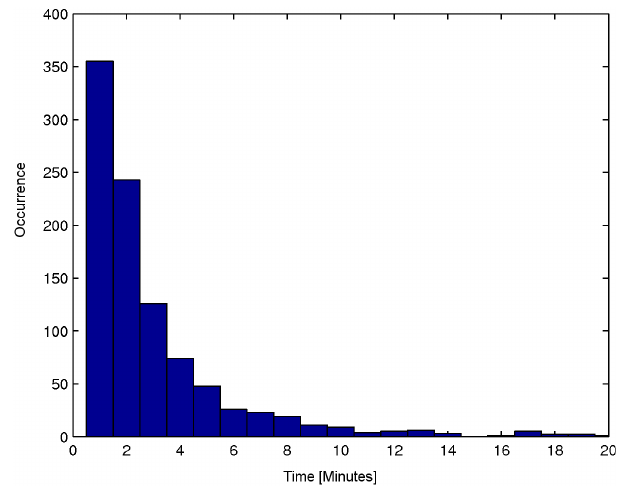
Fig. 10. Duration of continuously observed high electric field spec- tral density ( > 3(mVm − 1 ) 2 Hz − 1 ) at the O + gyrofrequency.